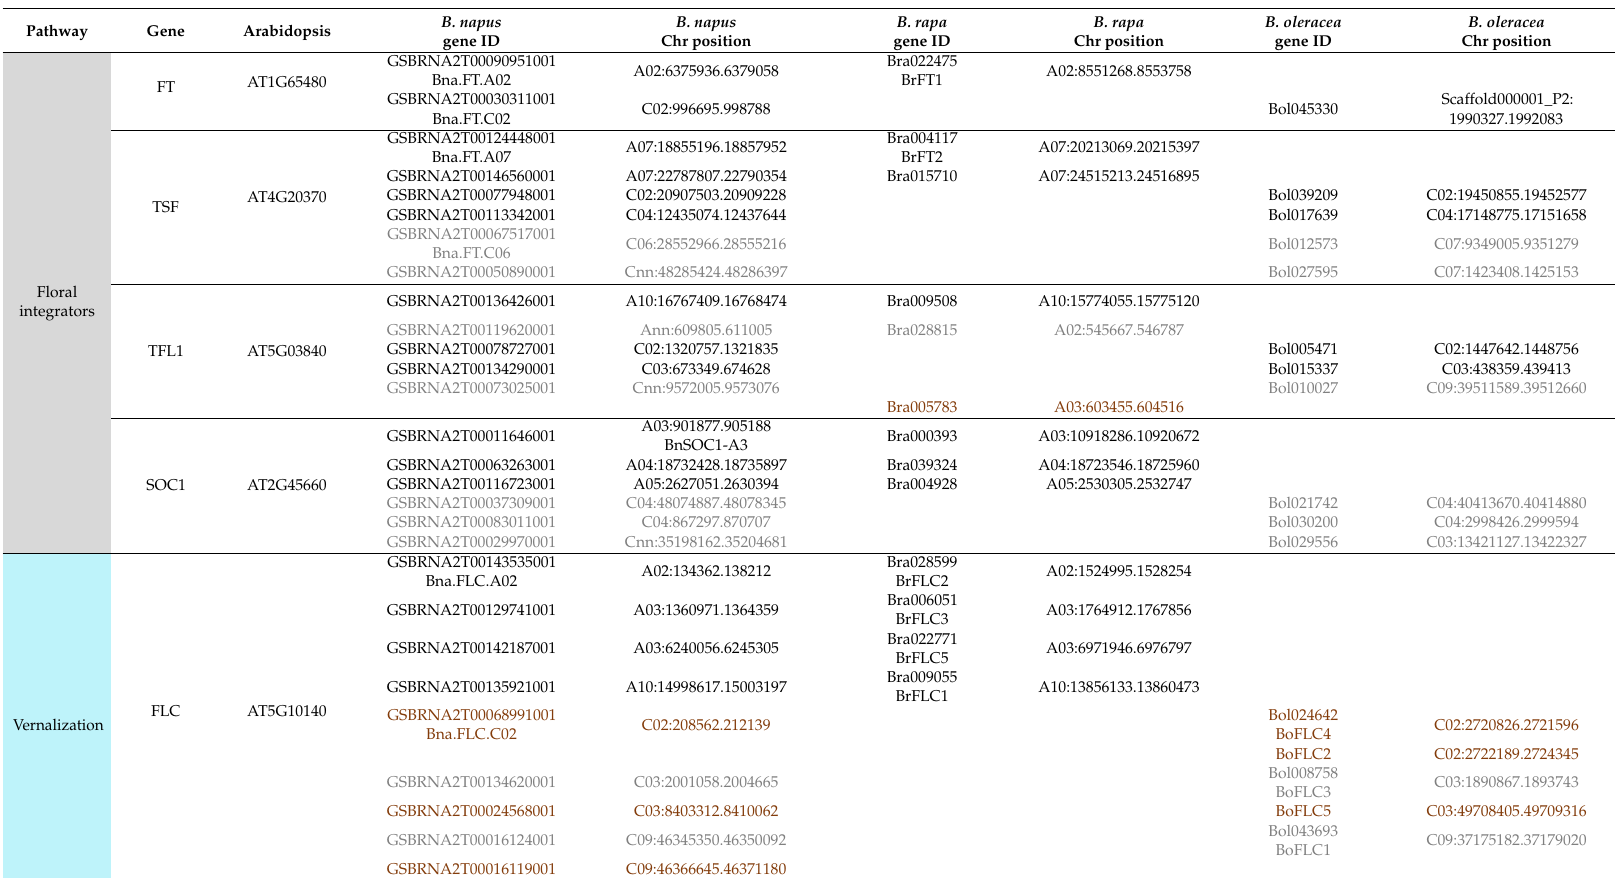
Table 3. Flowering time genes in Brassica